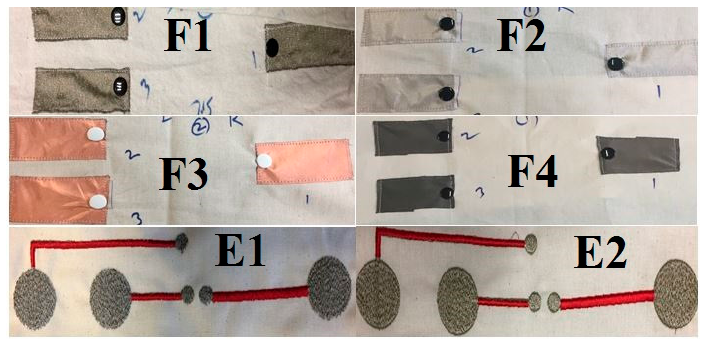
Figure 2. Di ff erent types of textile dry skin Figure 2. Different types of textile dry skin electrodes.